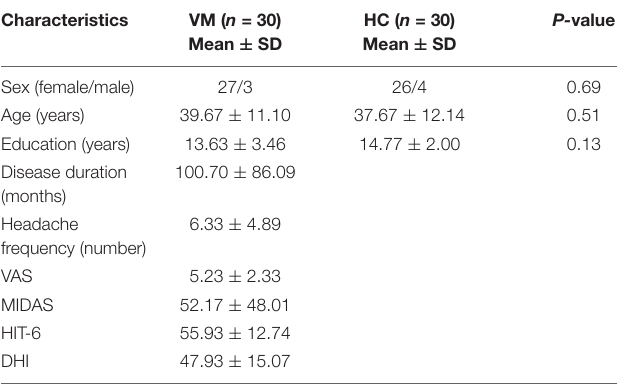
TABLE 1 | Demographic and clinical characteristics of